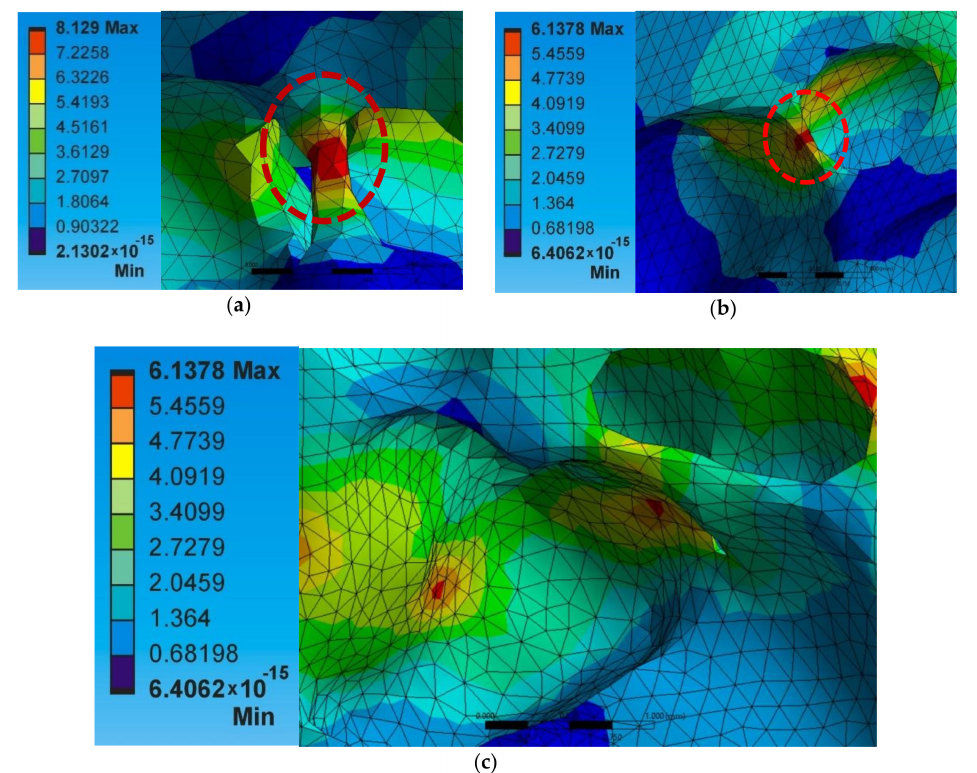
Figure 13. Maximum heat flux (W/mm 2 ) at ( a ) thin ligaments (A1 × 32) and ( b ) struts (A1 × 42), and ( c ) the heat flux distribution at the cell walls (A1 × 42)—52% foam porosity.